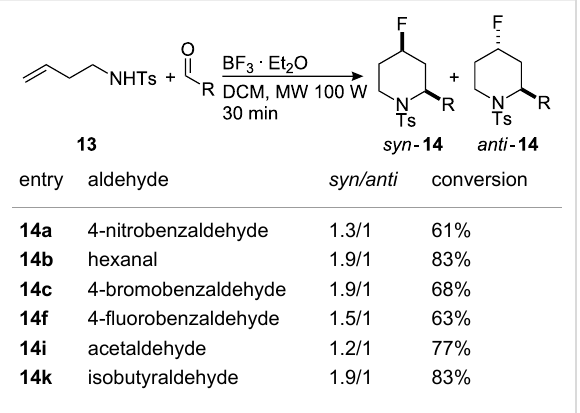
Table 6: aza-Prins reaction under microwave conditions. Reaction conditions: amine 13 (1 equiv), aldehyde (1 equiv), BF 3 ·OEt 2 , microwave 100 W, 50 °C, 30 min.